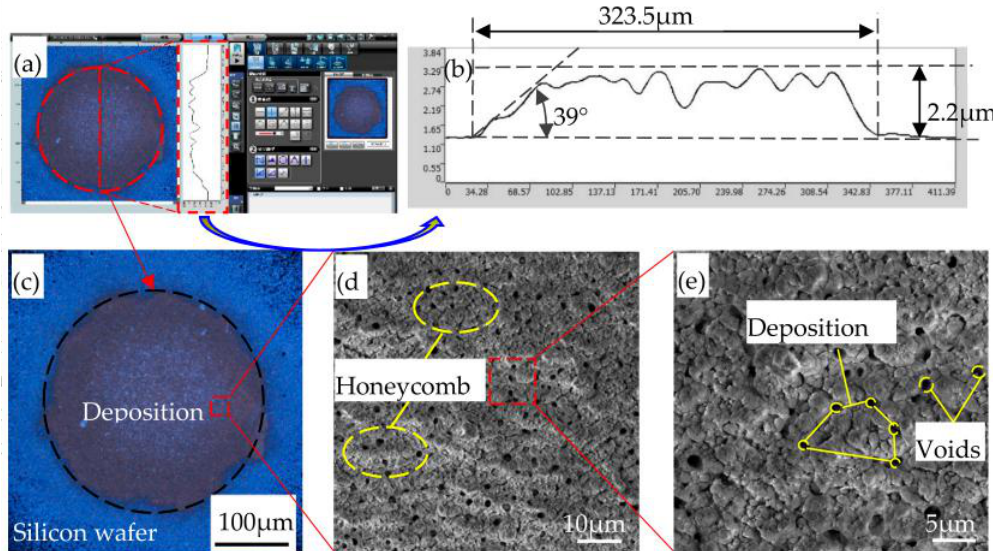
Figure 4. HV discharge deposition point ( a ) OLYMPUS microscope image of deposition point, ( b ) The image of deposition point contour scan, ( c ) Macroscopic image of HV discharge deposition point,